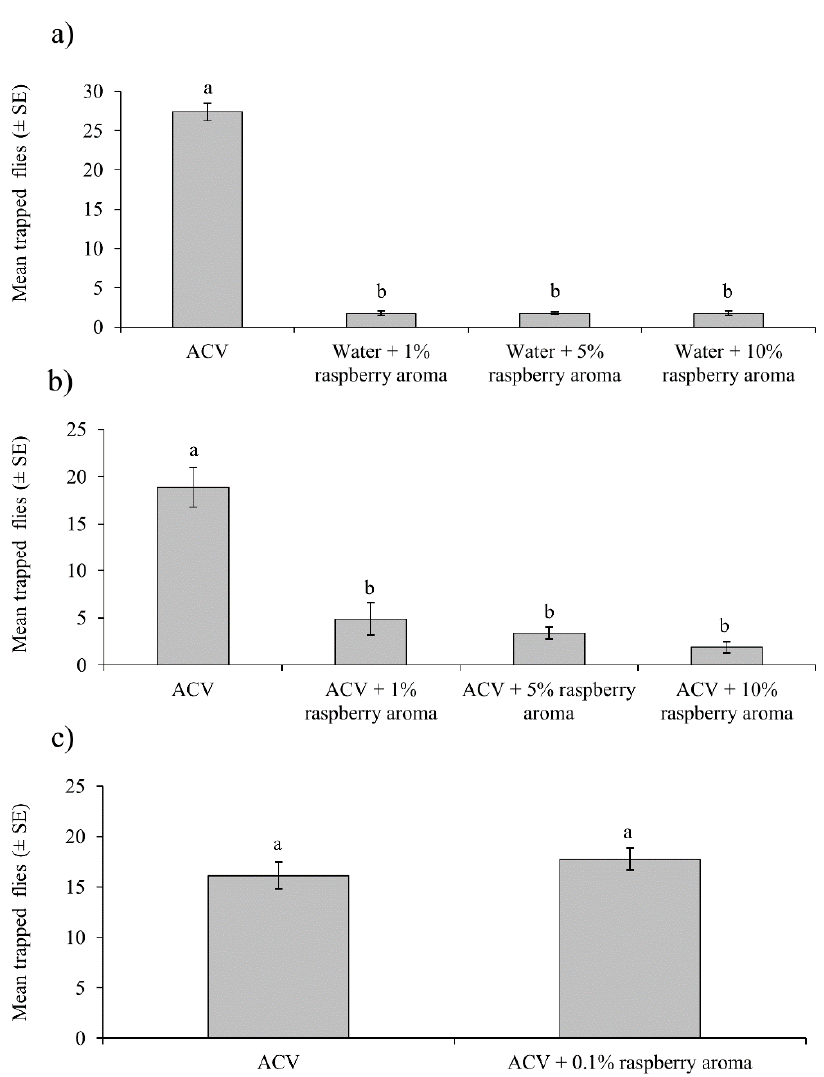
Figure 4. Mean numbers of D. suzukii (males and females) trapped in ACV or di ff erent treatments that contained synthetic raspberry aroma in water ( a ), in mixtures with ACV ( b ) or included at low concentration (0.1%) in ACV ( c ). Columns labeled with the same letter did not di ff er significantly (Tukey, p > 0.05).